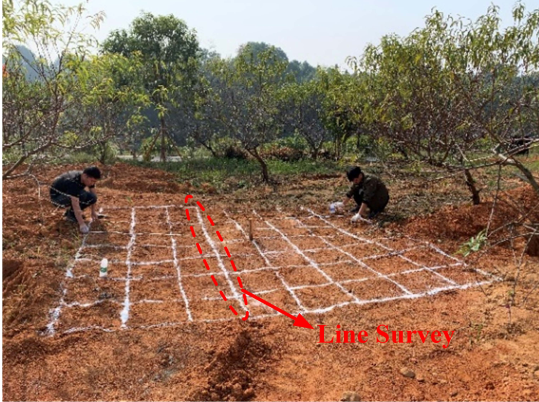
Figure 17. Photo showing the field collection of data.